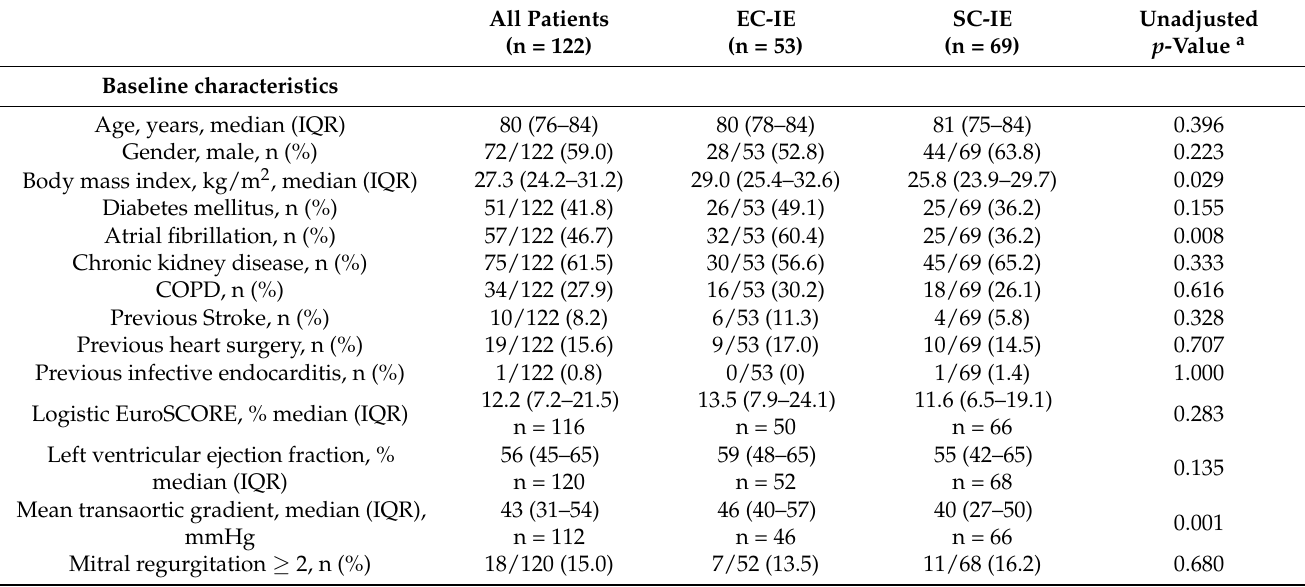
Table 1. Baseline